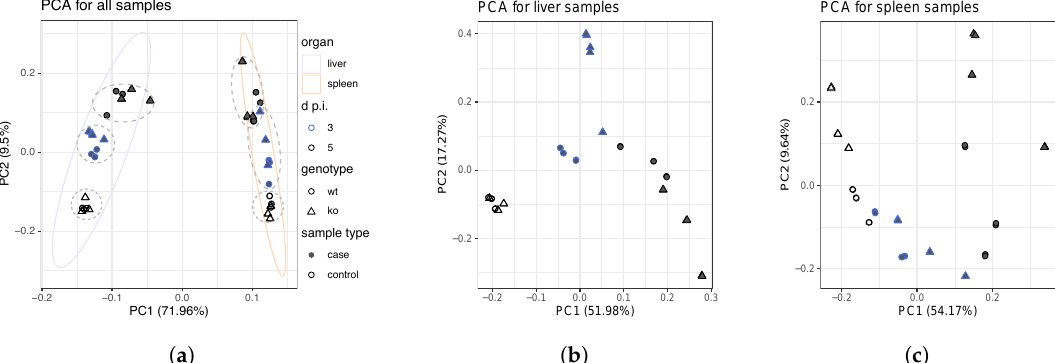
Figure 2. ( a ) PCA plot of the Log2-normalized counts for the exploratory analysis of all samples under study. The metric used for k-medoid partitioning was the Euclidean distance. Both replicates are included. Two groups, respectively corresponding to liver and spleen samples, are clearly differentiated. Dashed lines were added for improved visualization of the different groups that are distinguished within each organ. Organ-specific PCA for ( b ) liver and ( c ) spleen samples. Both replicates are included. PCA suggests the progressive nature of the MHV infection, where groups corresponding to mock infections, 3 d p.i. and 5 d p.i. are distinguished in varying degrees. Differences between controls and cases are more evident in liver samples. Figure 2a legend is the same for Figure